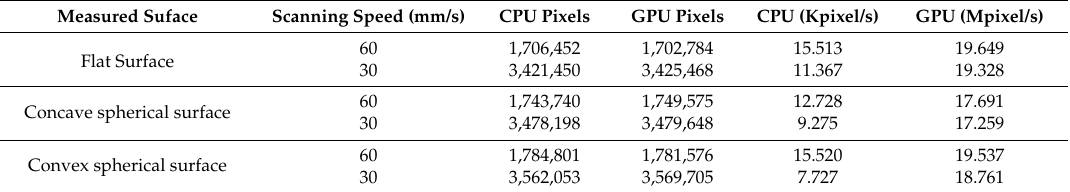
Table 3. Matching results.